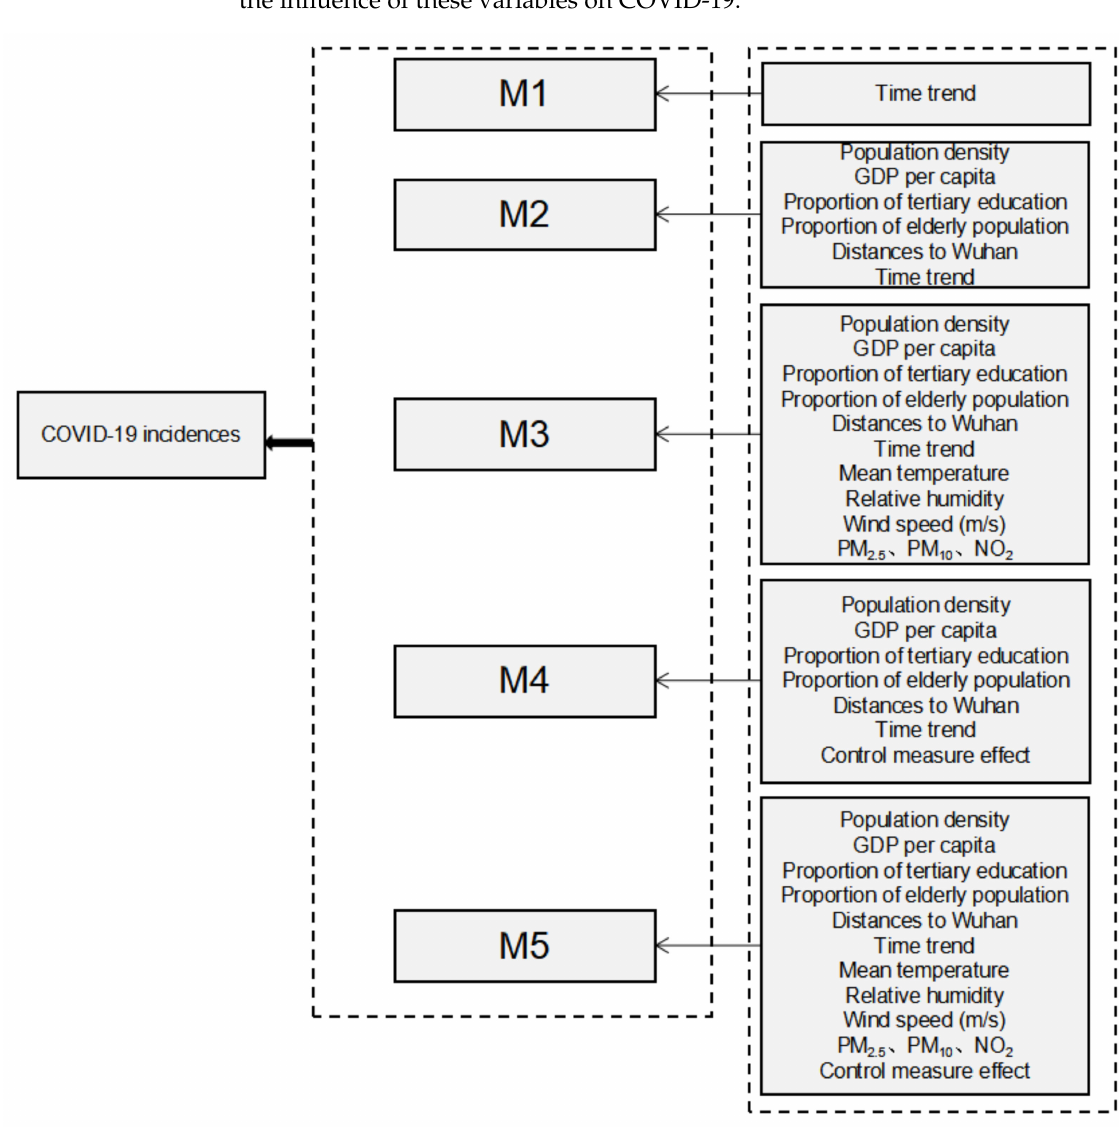
Figure 2. Variables included in the five